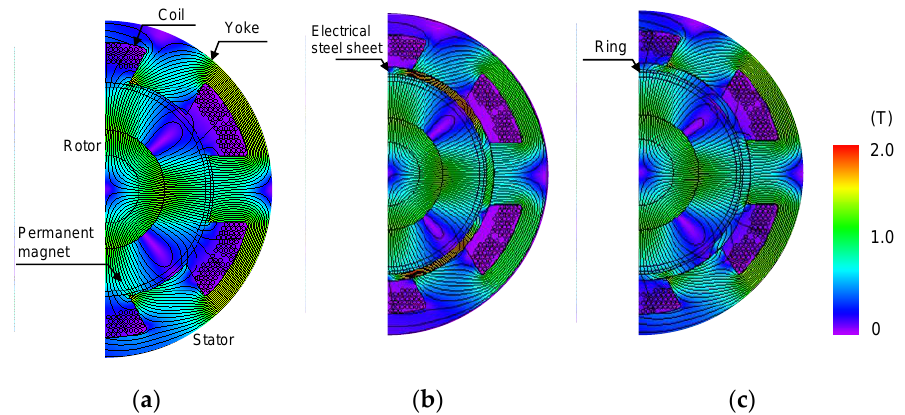
Figure 5. Magnetic flux density distributions ( N = 30,000 rpm, P o = 500 W): ( a ) open-slot motor, ( b ) closed-slot motor, and ( c ) ring motor.